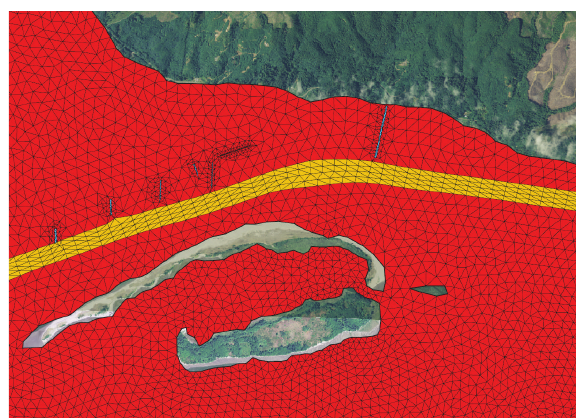
Figure 2: Example resolution near LCR Pile Dikes.